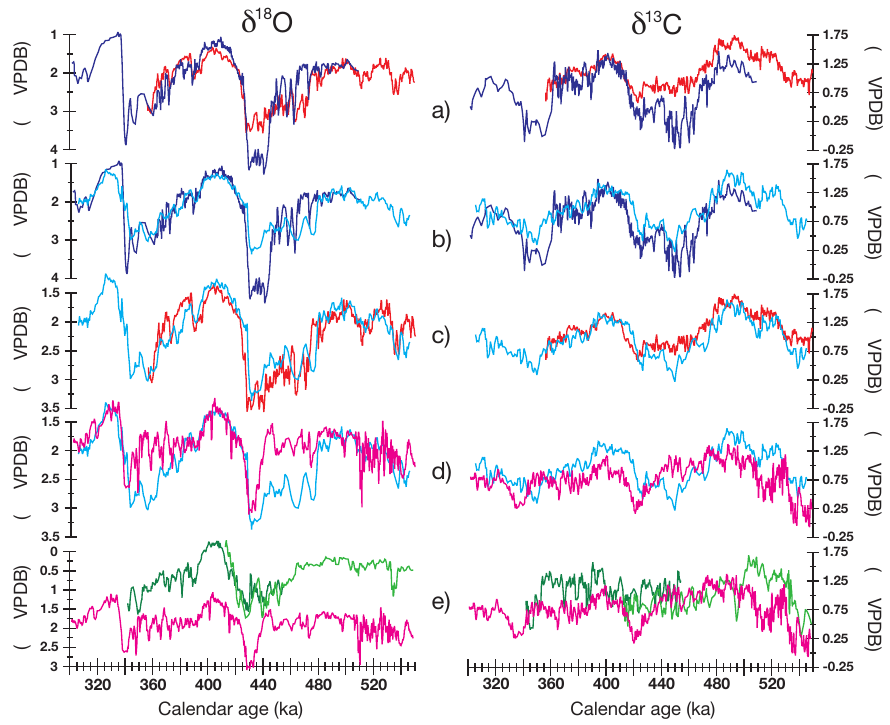
Fig. 8. Direct comparison between sites based on 3 point average records ( δ 18 O left, δ 13 C right side). Colors for sites as in Fig. 7. (a) IODP Site U1313 vs. ODP Site 980. For better comparison ODP Site 980 N. pachyderma ( r ) δ 13 C data was adjusted to dissolved inorganic carbon (DIC) by adding 0.85‰ (Labeyrie and Duplessy, 1985). (b) MD01-2446 vs. ODP Site 980 (with δ 13 C adjusted); (c) MD01-2446 vs. IODP Site U1313; (d) MD01-2446 vs. MD03-2699; (e) ODP Sites 1056 and 1058 vs.